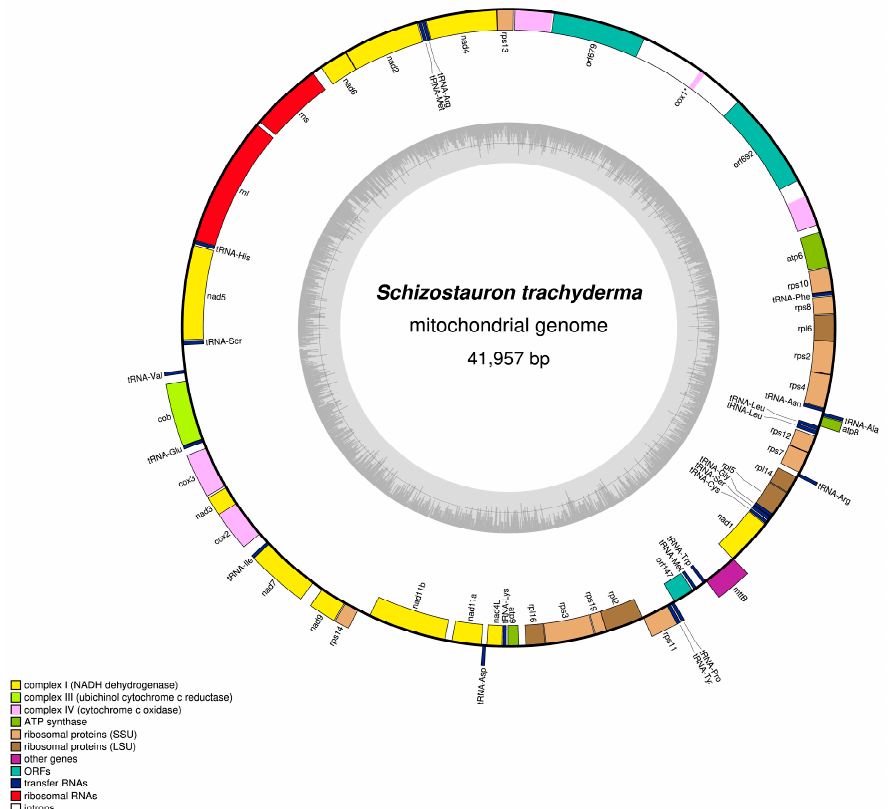
Figure 2. Map of the mitochondrial genome of S. trachyderma.